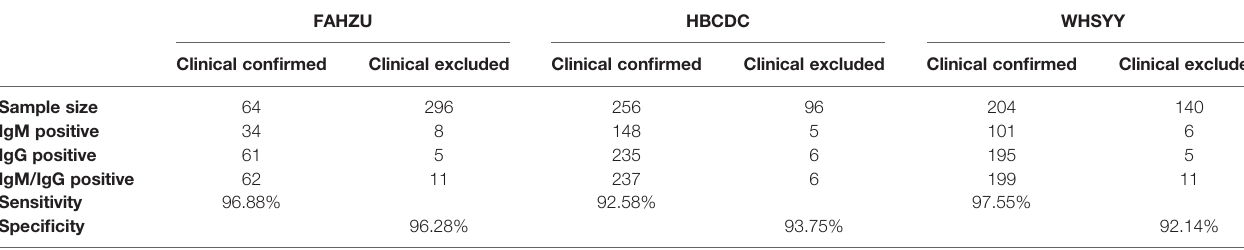
TABLE 2 | Sensitivity and speci fi city of ALLtest in of fi cial